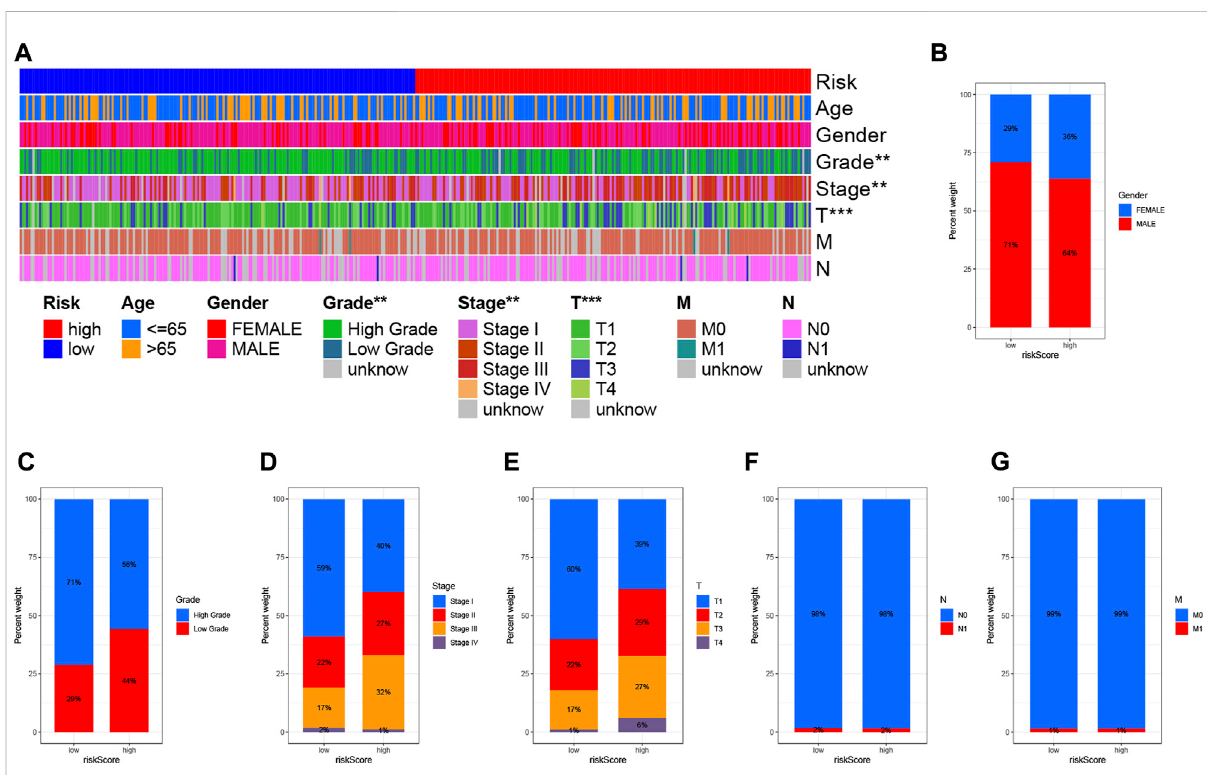
FIGURE 7 Clinical signi fi cance of prognostic risk characteristics. (A) Heatmap showing the distribution of clinical characteristics and corresponding risk scores in each sample. Incidence of clinical variable subtypes of LRG/HRG. (B) Gender, (C) Grade, (D) Clinical stage, (E) Stage T, (F) Stage N, and (G) Stage